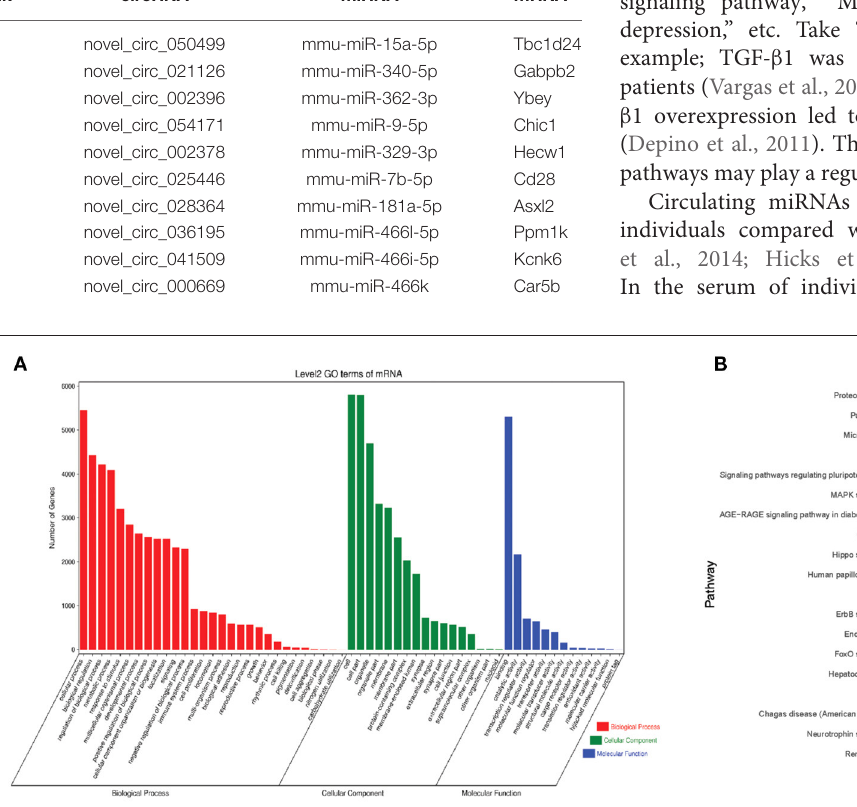
Frontiers in Genetics |